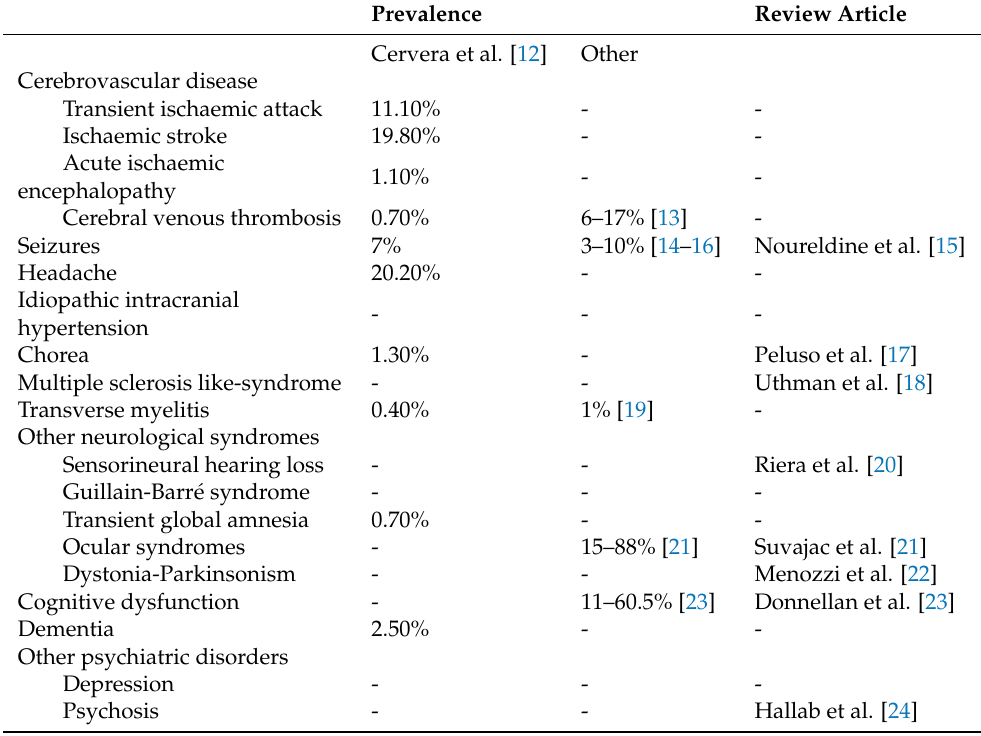
Table 1. Neuropsychiatric manifestations associated with the presence of antiphospholipid antibodies. The prevalence of each neuropsychiatric manifestation in APS patients is depicted in two columns. Firstly, the prevalence as described in the Euro-Phospholipid Project Group study, evaluating 1000 pa- tients with APS, by Cervera et al. [12], and then, any other articles that have described prevalence separately. The prevalence of some manifestations is unknown as they are based on anecdotal reports. Relevant review articles for each manifestation has also been included. Information in the table that is unavailable is denoted with a